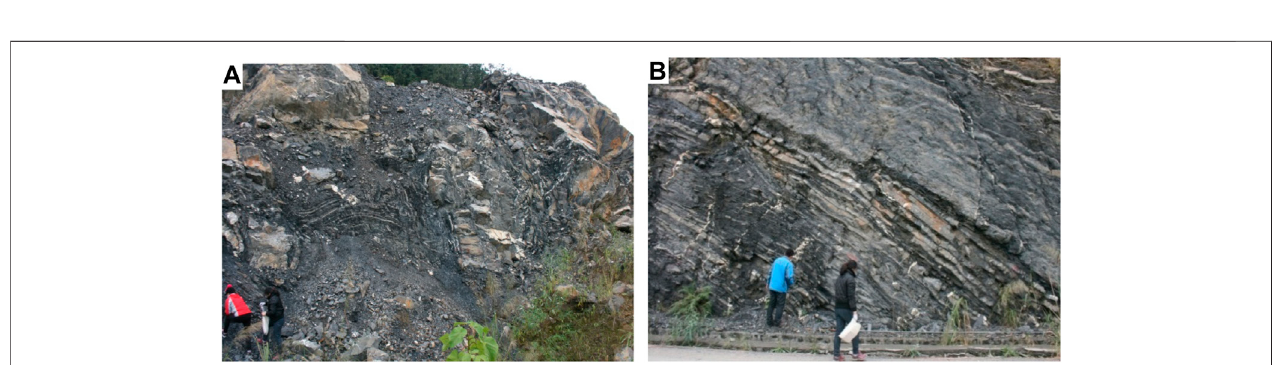
FIGURE 11 | Effectiveness of marl sealing in different structural parts. (A) Strongly folded marl destruction in the core of anticline, sealing failure. (B) Fractures in wing shale are interrupted in limestone and fi lled with calcite, sealing effective.